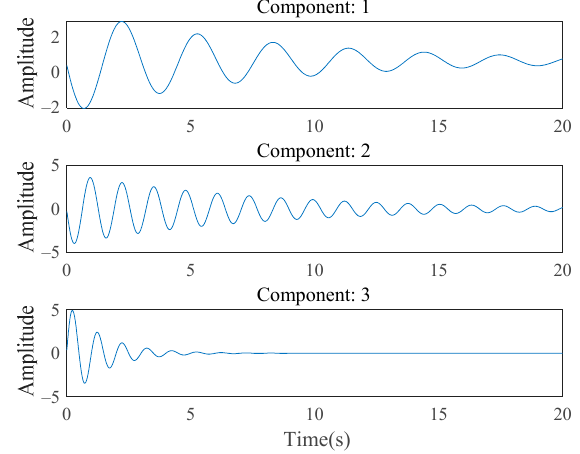
Figure 7. Dominant components of signal A identified by SMPI. The three signal components are superimposed to obtain a synthesized signal after SMPI as Equation (27).